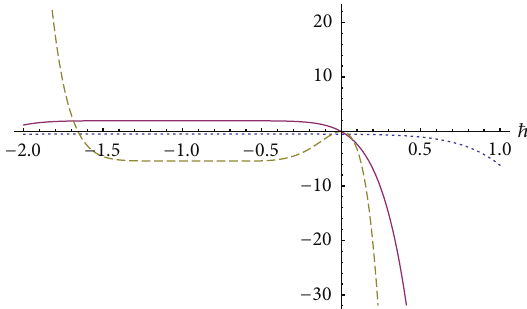
Figure 1: The HAM solution of KdV whereby forcing term is zero. agreement with Wazwaz’s exact solution of KdV equation.